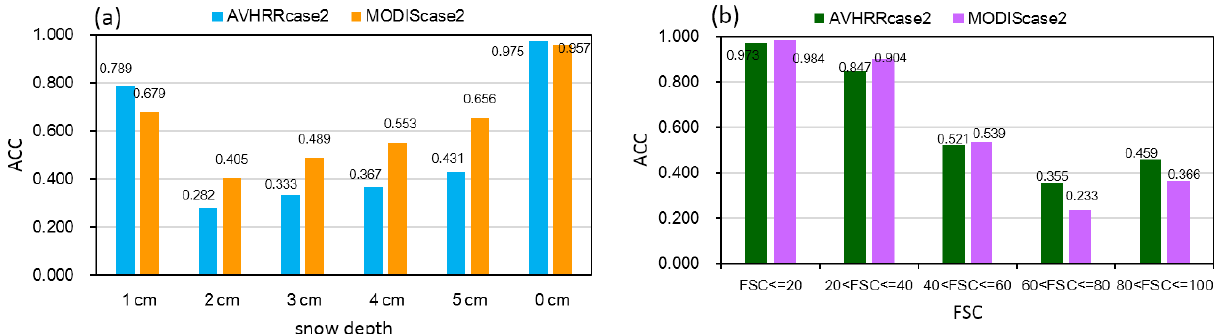
Figure 7. The variation in ACC with snow depth (a) and FSC (b) for AVHRR raw and MODIS snow data throughout the sites during the experimental period.